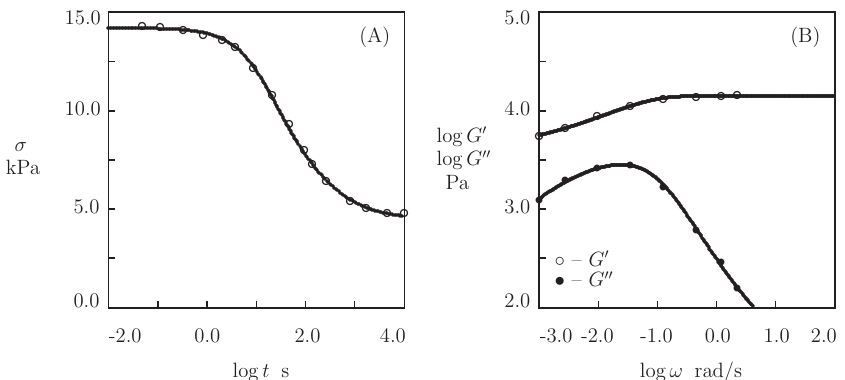
Figure 8. ( A )–Shear stress σ versus relaxation time t . ( B )–Storage modulus G (cid:48) and loss modulus G (cid:48)(cid:48) versus frequency ω . Symbols: experimental data [47] on PEG-EPE gel. Solid lines: the results of simulation.